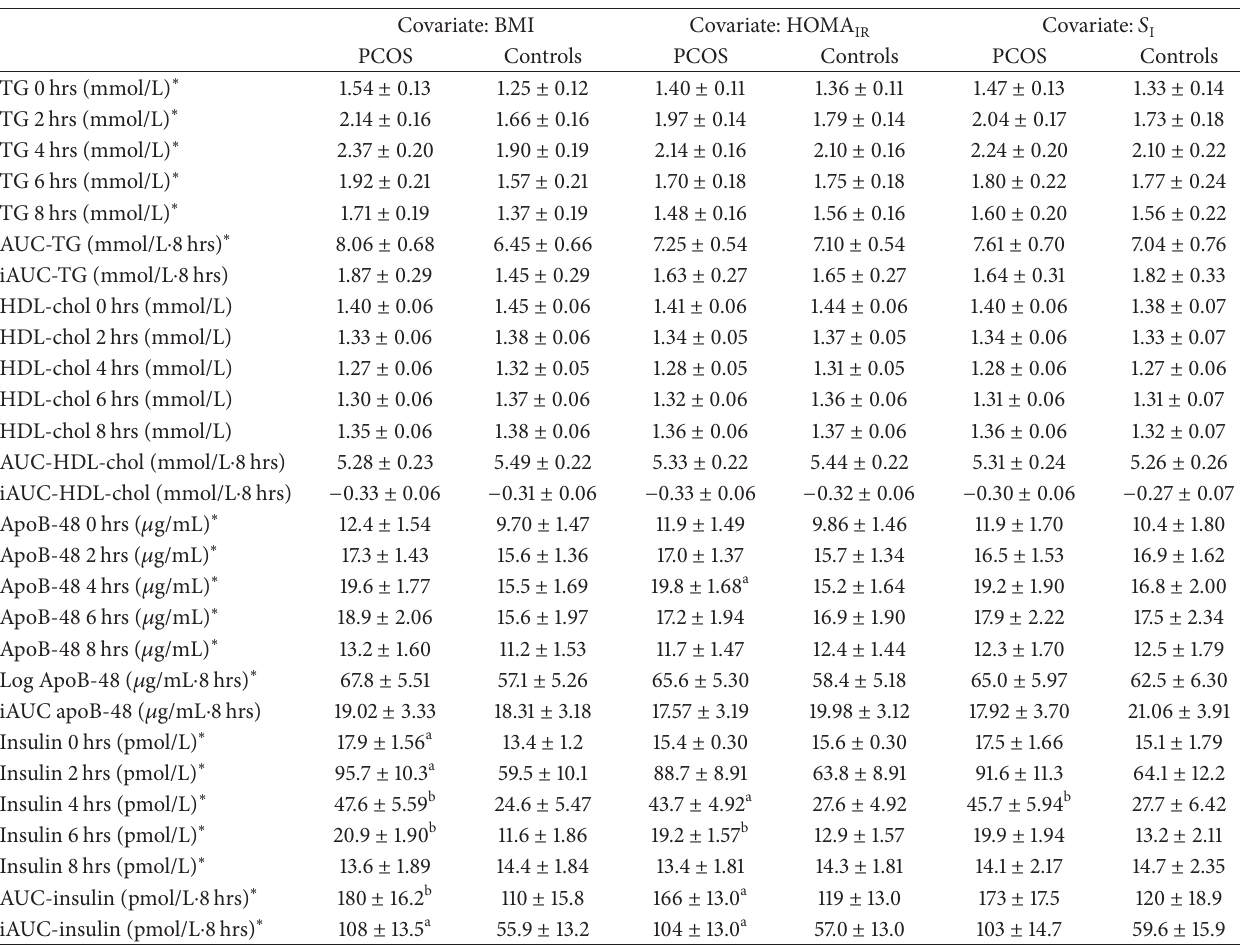
Table 5: Postprandial TG, HDL, apoB-48, glucose, and insulin levels adjusted for BMI, HOMA IR , and 𝑆